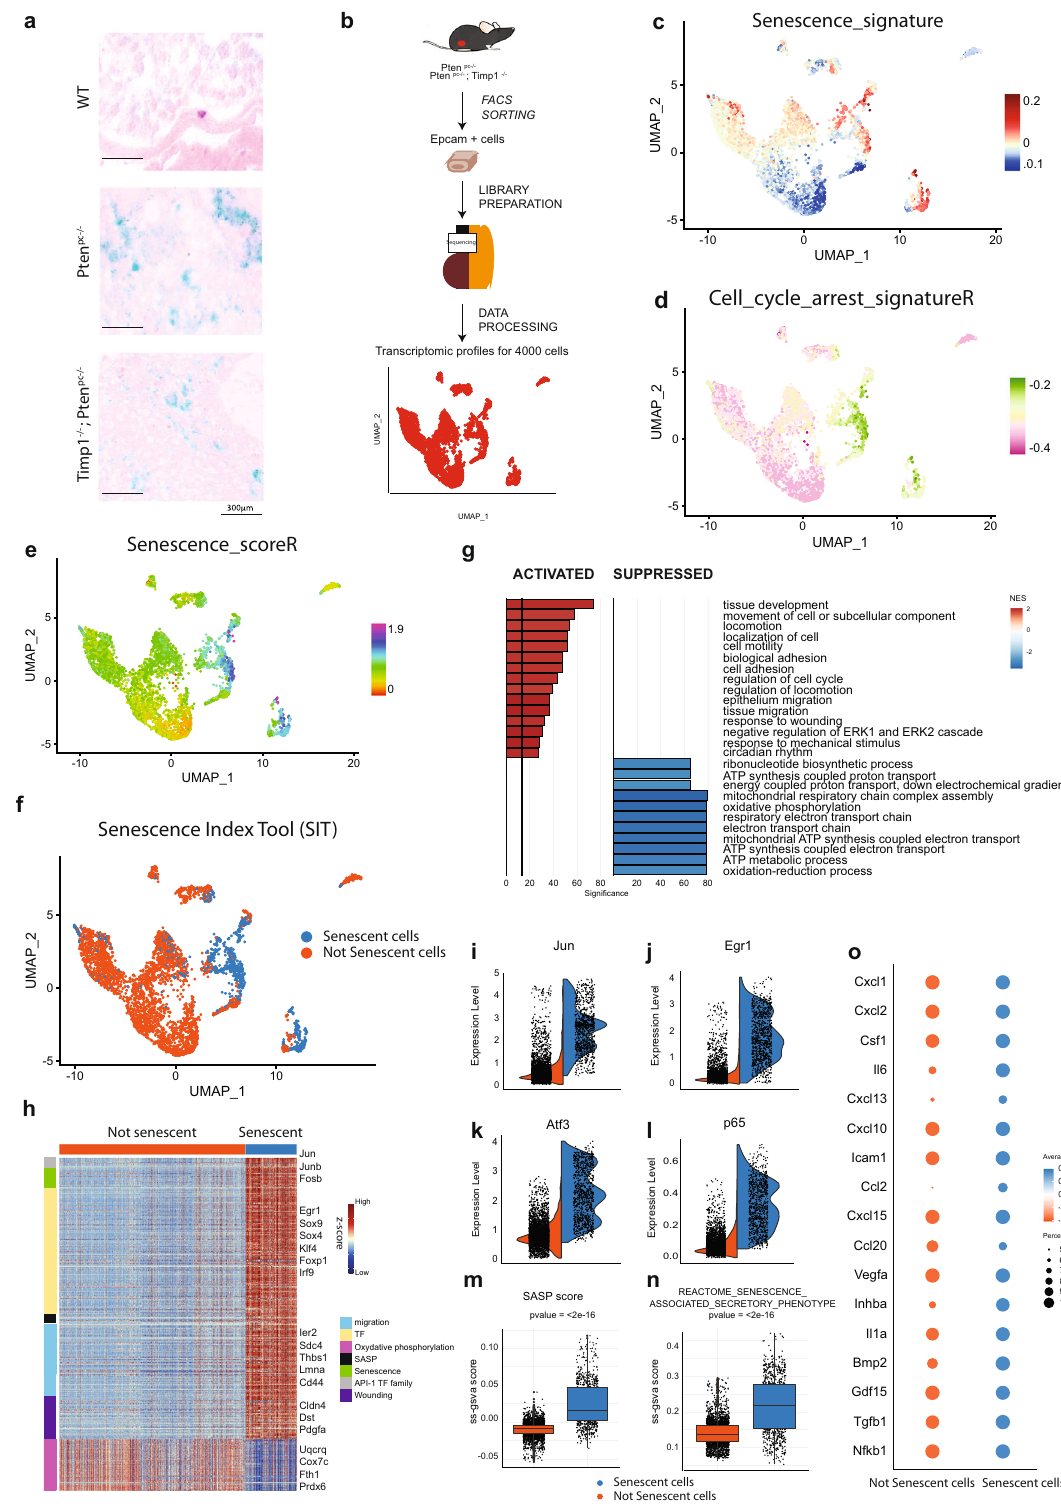
cascaderesponse to stimulusnegative regulation of ERK1 and ERK2 processcircadian rhythmresponse to mechanical transportribonucleotide biosynthetic assemblyenergy coupled proton transport, down electrochemical gradientATP synthesis coupled proton phosphorylationmitochondrial respiratory chain complex